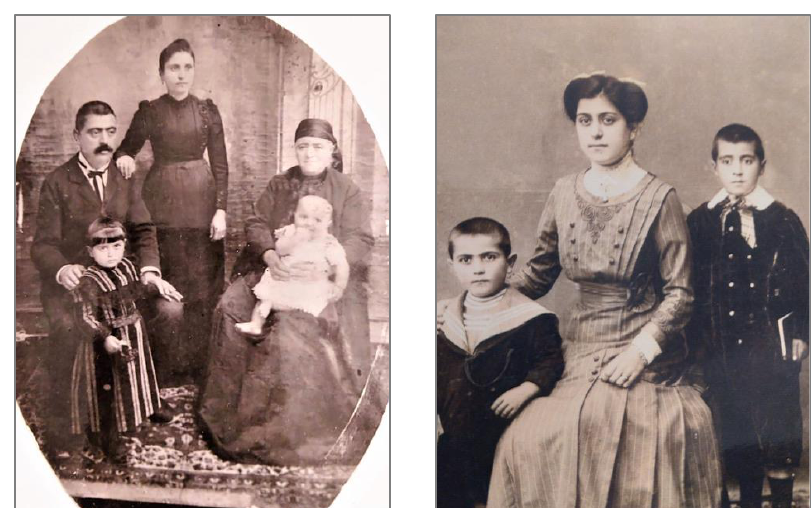
Figure 3, 4 Photos of family members living in Karaman Mansion (figure 3 was taken circa 1901. Artin (Haroutune)